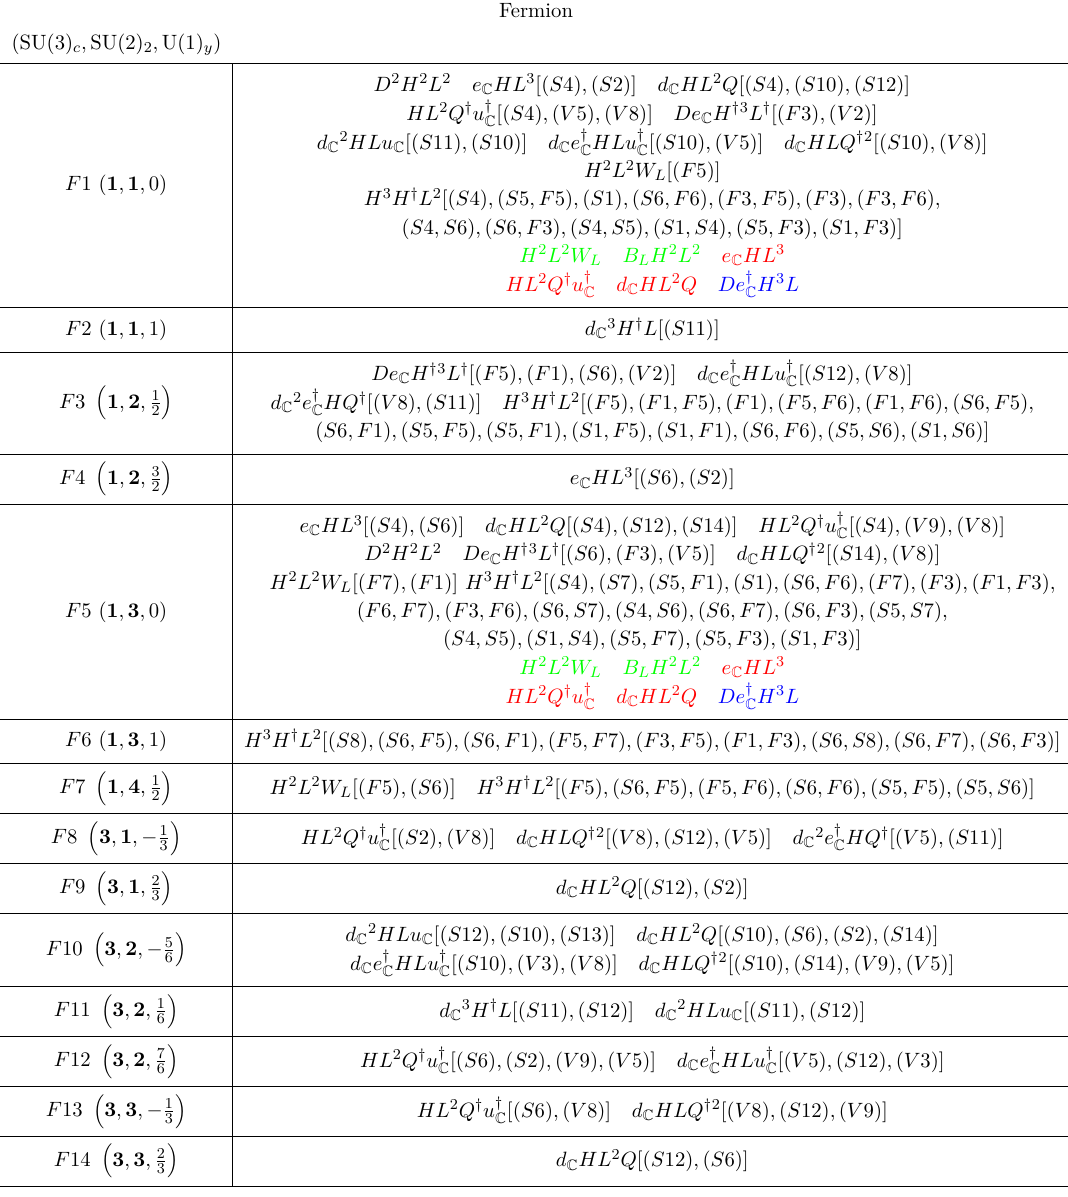
Table 19 . Fermion resonances which could generate the dim-7 operators. The name of the reso- nances is organized by the gauge quantum number. The resonance appeared in the squared bracket of the operator indicate that both resonances are needed to generate such